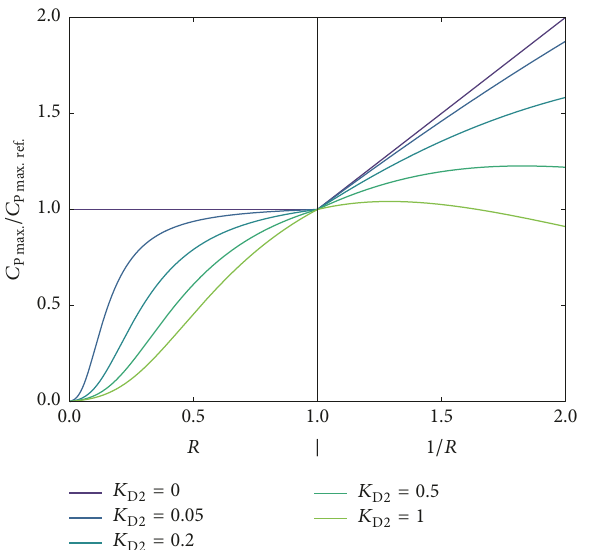
(that will result in opt . /𝐶 ) plotted as a Pmax . Pref . for various values of the static D 2 D 0